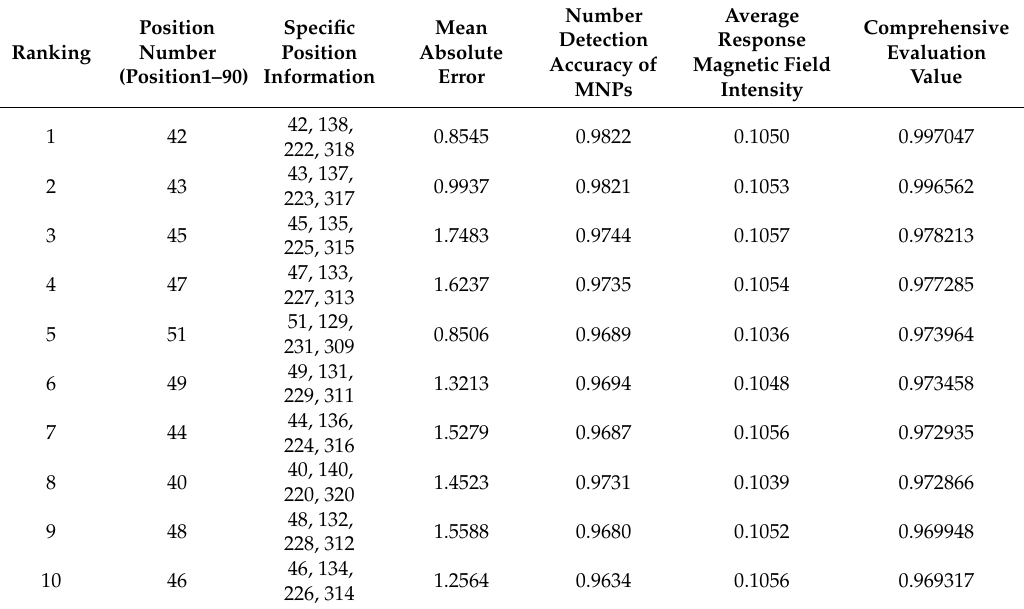
Table 6. Ranking of comprehensive evaluation values corresponding to Position1–Position90 and specific position information (top 10 positions).